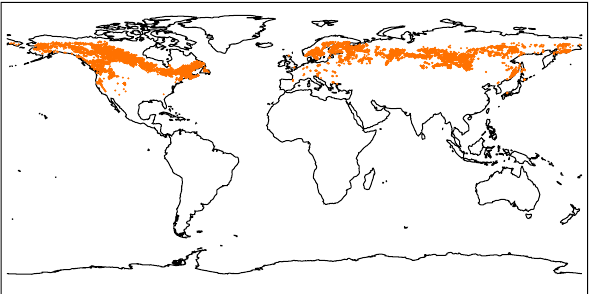
Fig. 2. The locations of measurements that the new snow and forest test indicates as being snow-covered forests instead of clouds during January 2003. All locations are found over boreal